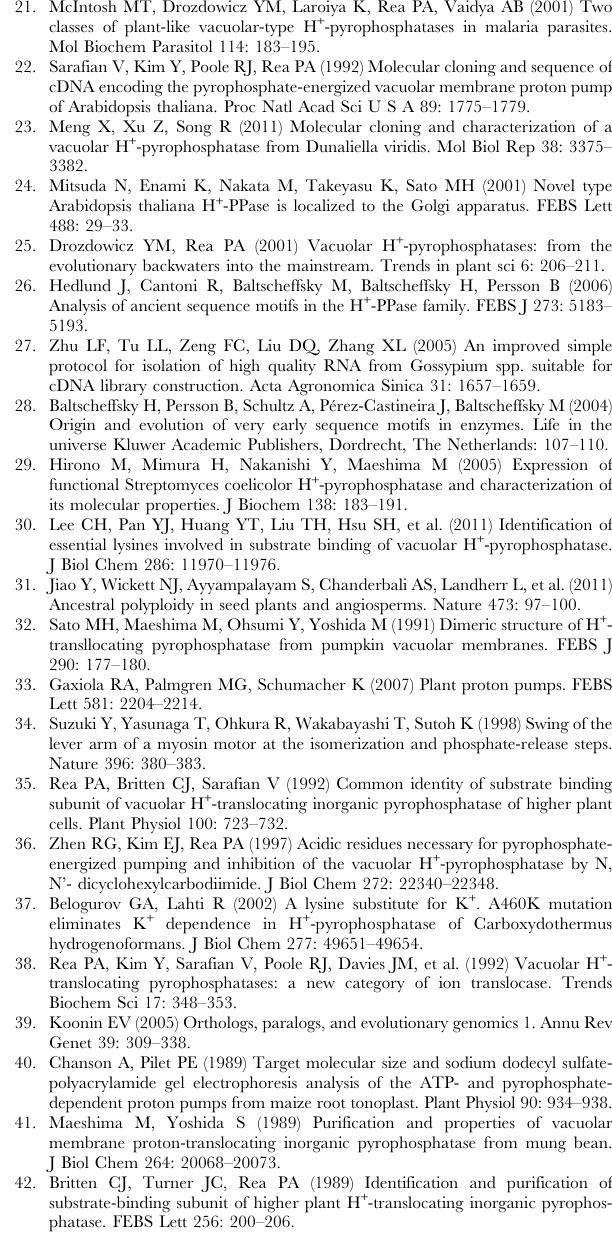
Figure S4 Predicted 3D structure of the H + -PPases in bacteria and protozoans. The gene name and accession number of these identified H + -PPases are the same as in Figure 5.